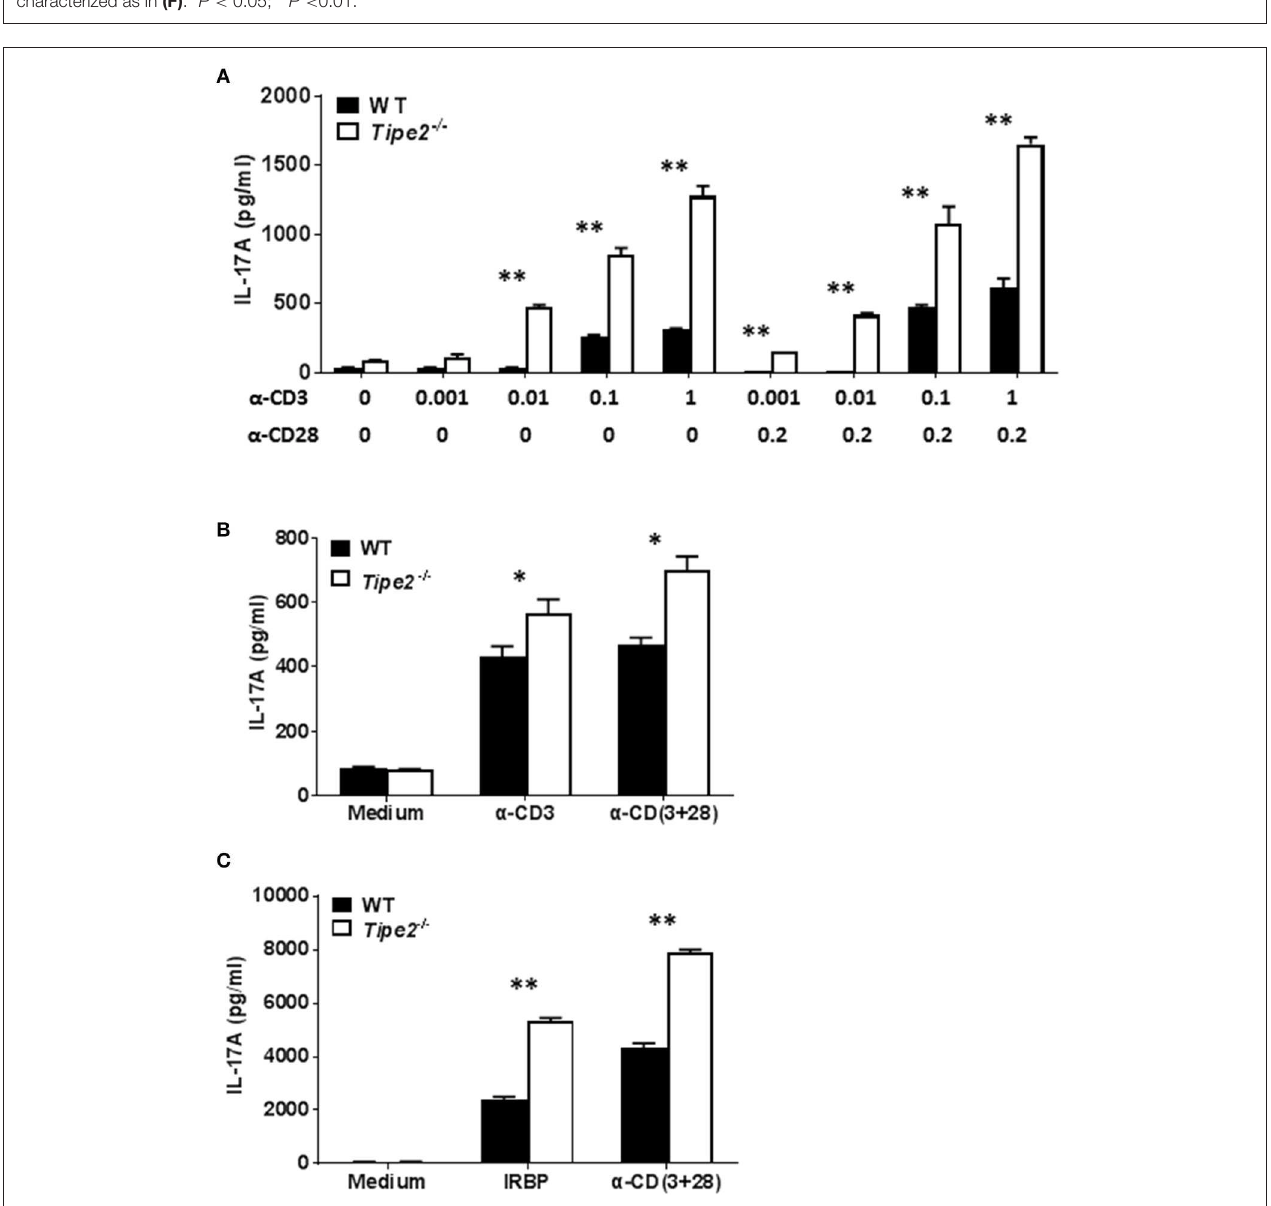
FIGURE 2 | TIPE2 suppresses IL-17A production by splenic T cells. (A) CD4 + T cells were isolated from untreated WT ( n = 3) and TIPE2-deficient mice ( n = 3) and cultured with or without different concentrations ( µ g/ml) of plate-bound anti-CD3 plus soluble anti-CD28 as indicated. After 48h, culture supernatants were collected and the concentration of IL-17A was determined by ELISA. Data are representative of three separate experiments. (B) WT ( n = 5) and TIPE2-deficient ( n = 5) mice were treated as in Figure 1A and killed 3 days after the first IMQ treatment. Total splenocytes were isolated and cultured at 1 million per well in 96-well plate with or without plate-bound anti-CD3 (0.5 µ g/ml) or/and anti-CD28 (0.5 µ g/ml). After 48h, the concentration of IL-17A in the culture supernatants was determined by ELISA. Data are representative of two separate experiments. (C) EAU was induced in WT ( n = 4) and TIPE2-deficient ( n = 5) mice as in Figure 1E and killed 21 days following immunization. Total splenocytes were isolated and cultured at 1 million per well in 96-well plate with or without IRBP (30 µ g/ml) or anti-CD3 (0.5 µ g/ml) plus anti-CD28 mAb (0.5 µ g/ml). After 48h, the concentration of IL-17A in the culture supernatants was determined by ELISA. Data are representative of two separate experiments. * P < 0.05; ** P <